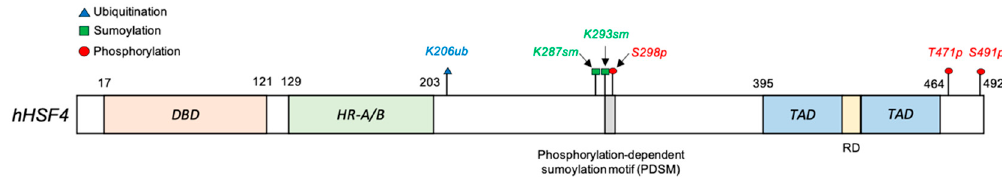
Figure 5. HSF4 protein post-translational modifications (PTMs). Three phosphorylation and two sumoylation sites and one ubiquitylation site have been reported for HSF4.